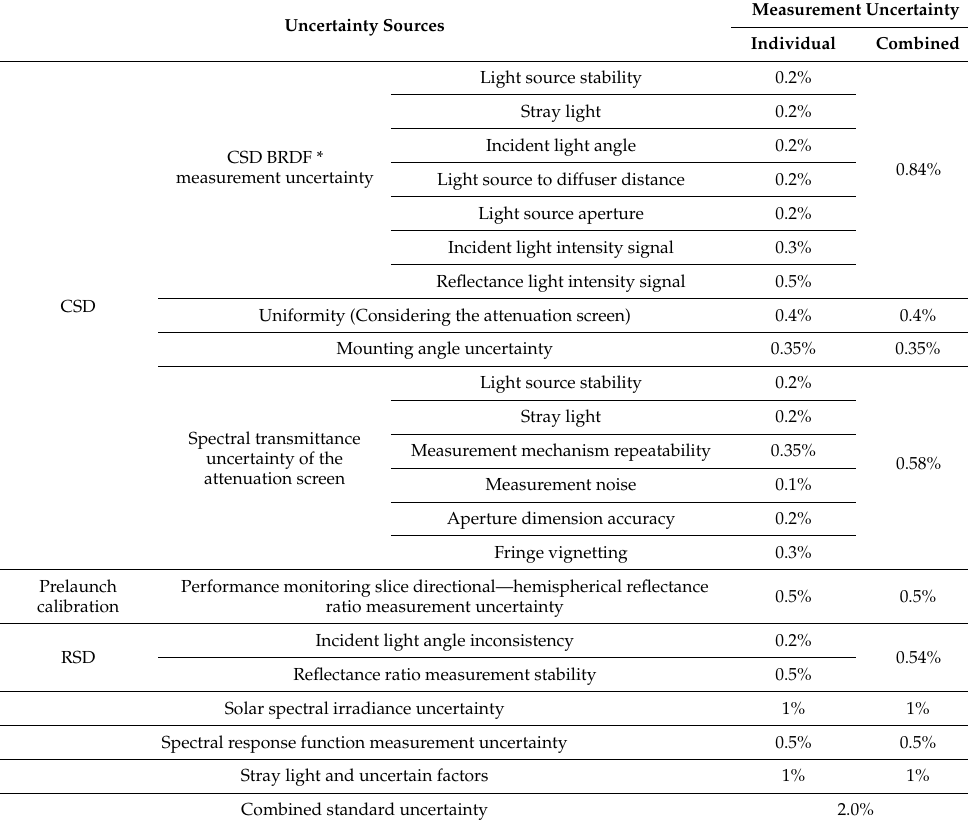
Table 1. Relative standard deviations of eight spectral bands between SCS and